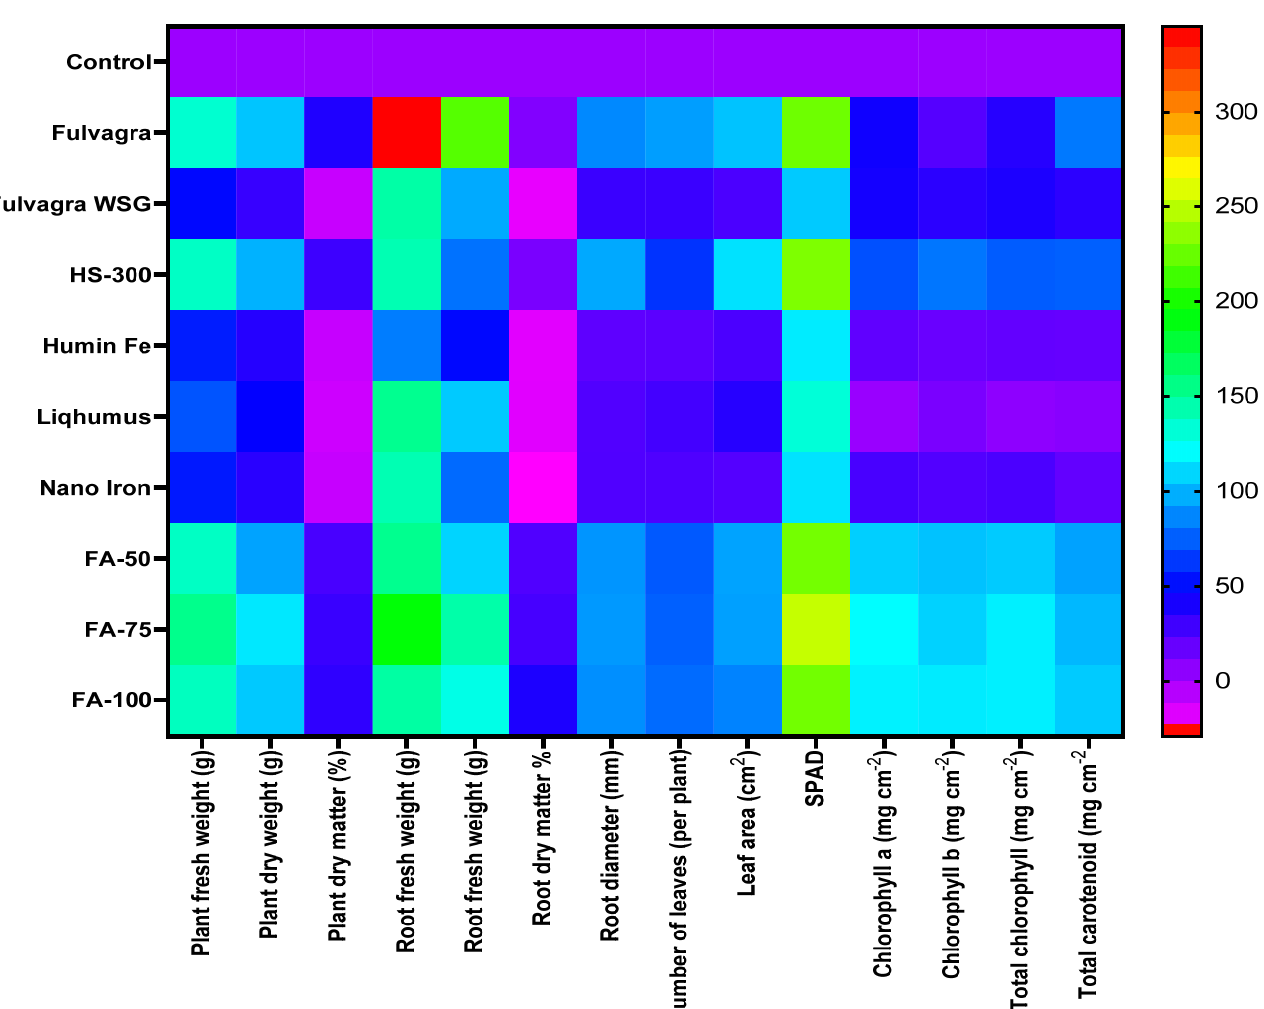
Figure 6. Heatmap analysis for percentage change (%) of the growth parameters and chlorophyll and carotenoid contents of spinach with different treatments compared with the control.